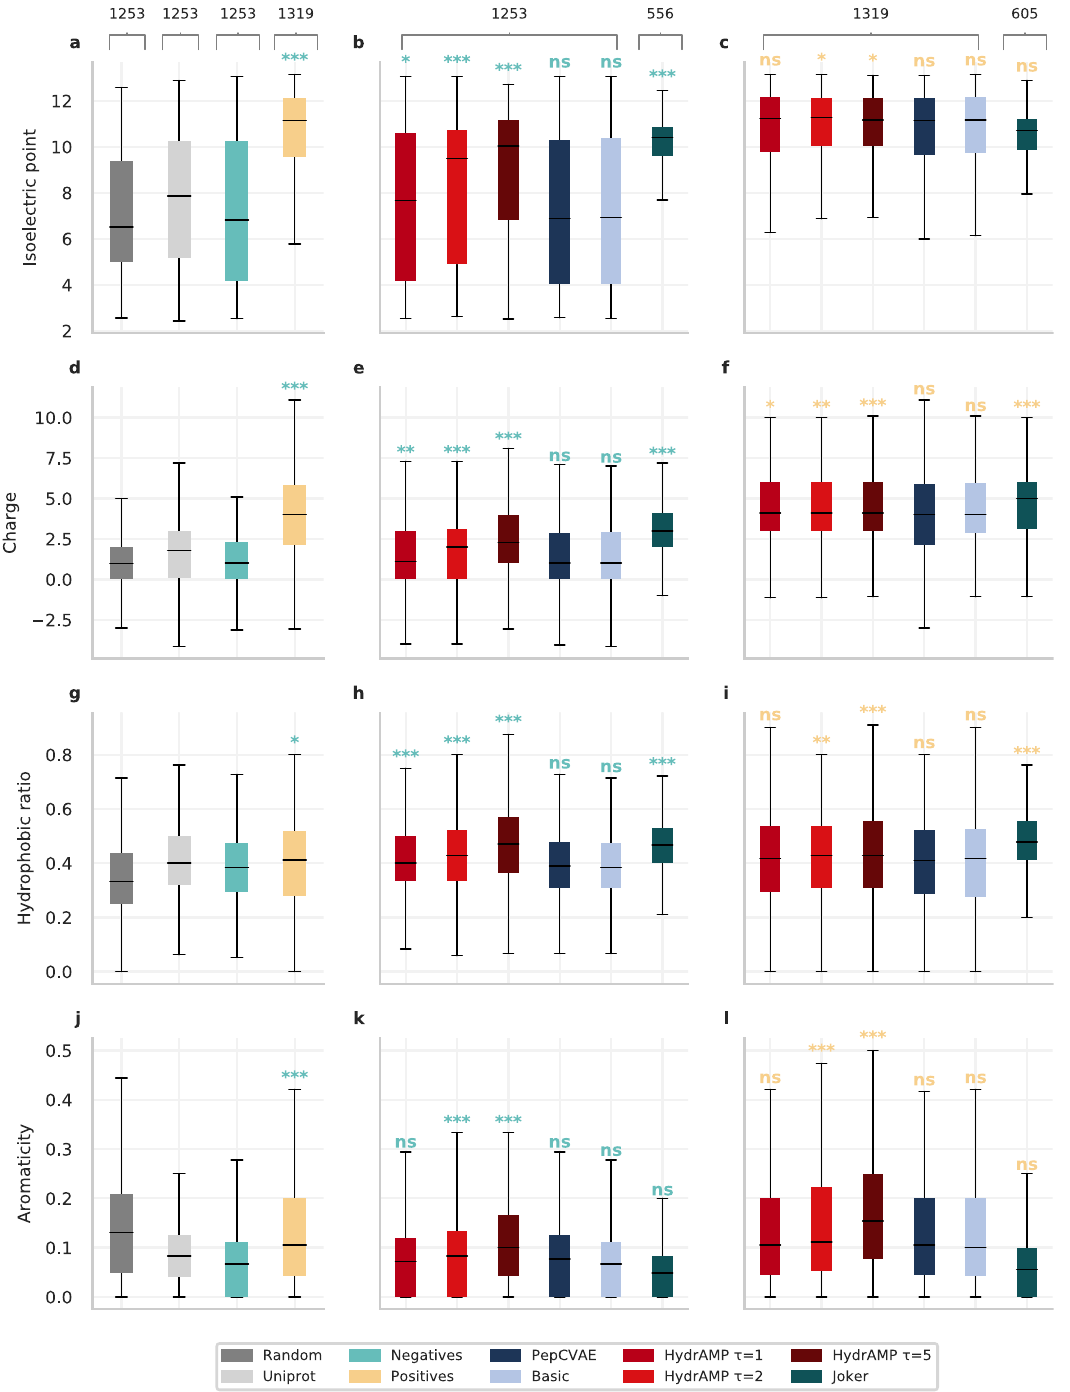
Fig. 5 | Physicochemical properties of analogues generated by HydrAMP and comparedmethodsinanaloguegenerationfornon-AMPorAMPprototypesin comparison with real and random data. Distributions of properties ( a, b, c Iso- electric point, d, e, f Charge, g, h, i Hydrophobic ratio, j, k, l Aromaticity) of randomly generated peptides (dark gray; sample size n =1253;), peptides sampled from UniProt (light gray; n =1253), true negatives (green; n =1253), and true posi- tives (yellow; n =1319), in comparison with AMP analogues generated from nega- tives( b, e, h,k ), andpositives( c,f,i,l )bydifferentmodels:HydrAMP withvarious creativityparameter temperature values: τ =1(lightred), τ =2(red), τ =5(darkred), PepCVAE(darkblue),Basic(lightblue),andJoker(darkgreen).HydrAMPgenerated